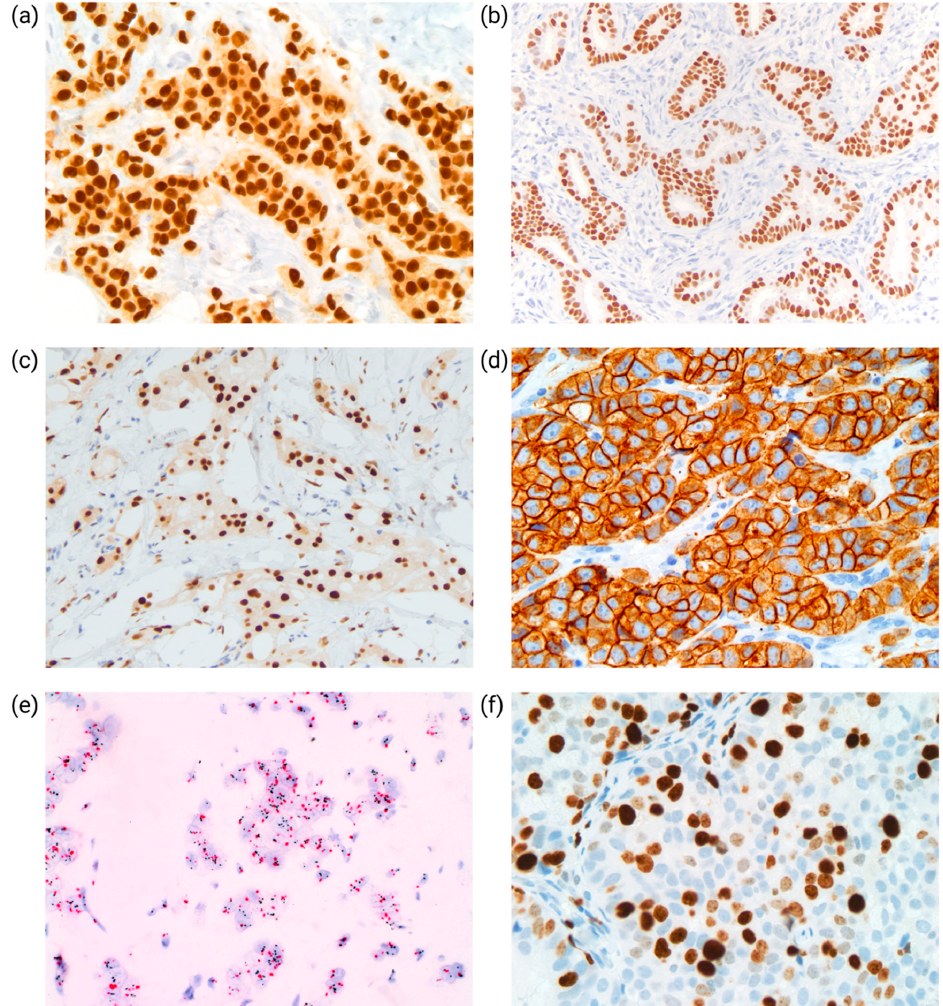
Figure 2. Biomarker analysis for subtyping of breast cancer. ( a ) ER expression by IHC; this is a positive ER with strong nuclear staining in >90%. ( b ) PR expression by IHC; this is a positive PR with moderate to strong nuclear staining in >90%. ( c ) AR expression by IHC; this is a positive AR with strong nuclear staining in >90%. ( d ) HER2 expression by IHC; this is a HER2 3+ positive with strong complete membranous immunoreactivity. ( e ) HER2 amplification by CISH; HER2-positive breast cancer identified by HER2 chromogenic in situ hybridization (CISH). The HER2 gene copy number increase is detected using a HER2 -specific probe (black signal), commonly co-hybridized to tumor cell nuclei using a second probe specific to the centromeric region of chromosome 17 (red